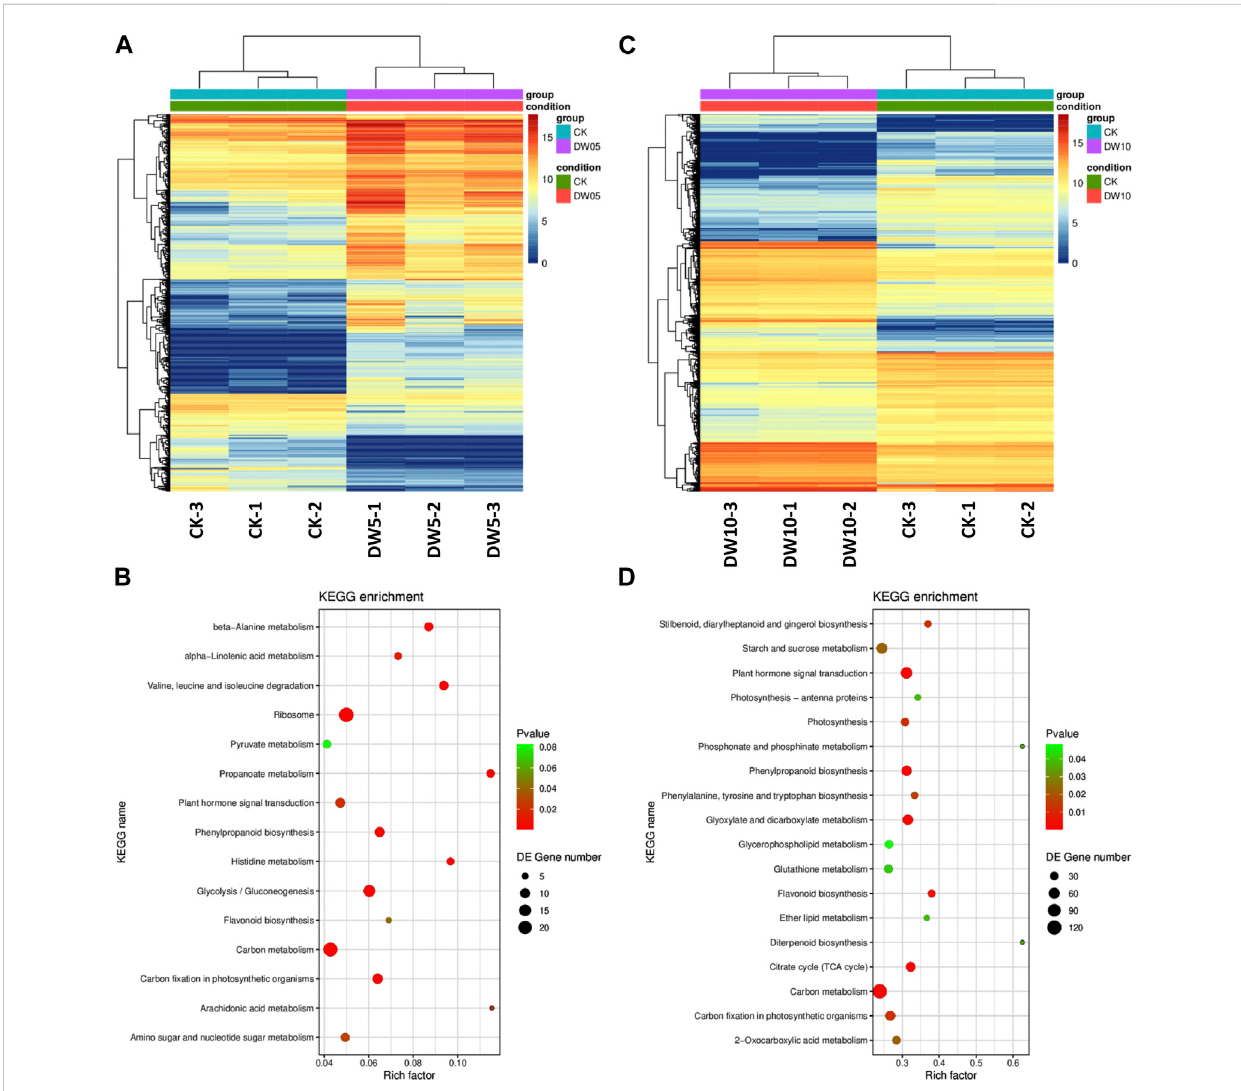
FIGURE 5 Half-waterlogging stress driven transcriptome changes in Adiantum leaves. (A) Heat map representation of expression pro fi les for differentially regulated genes in response to 5 days of half-waterlogging stress. (B) Heat map representation of expression pro fi les for differentially regulated genes in response to 10 days of half-waterlogging stress. (C) Scatter plot showing the pathways to which the DEGs were signi fi cantly enriched after 5 days of half-waterlogging. (D) Scatter plot showing the pathways to which the DEGs were signi fi cantly enriched after 10 days of half-waterlogging. Where, CK = control, DW05 = half-waterlogging for 5 days, and DW10 = half-waterlogging for 10